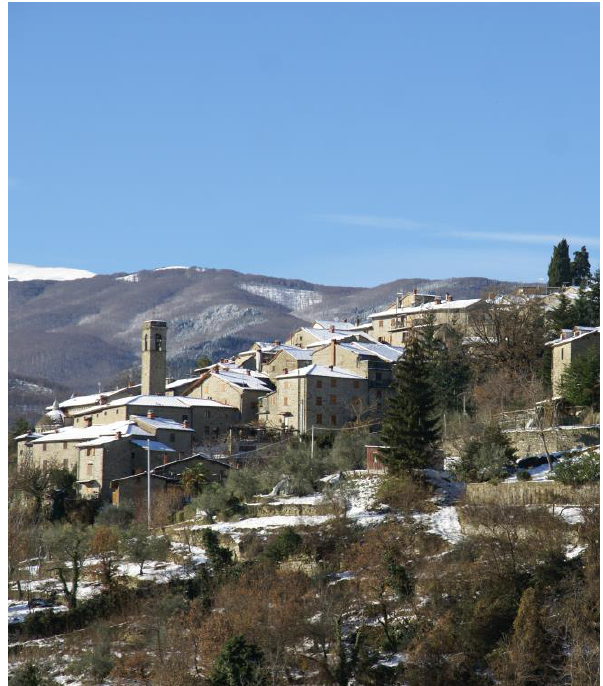
Figure 1. The village of Quota on the slopes of Pratomagno on the side of the Casentino